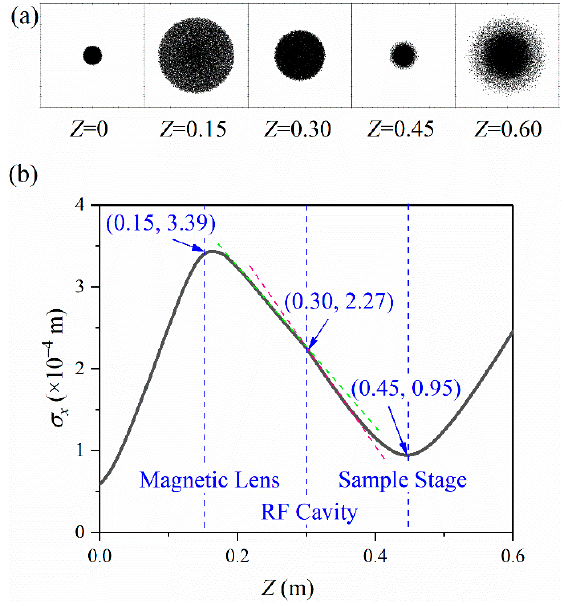
Figure 2. Transverse shape ( a ) and radius σ x ( b ) evolve during propagation.